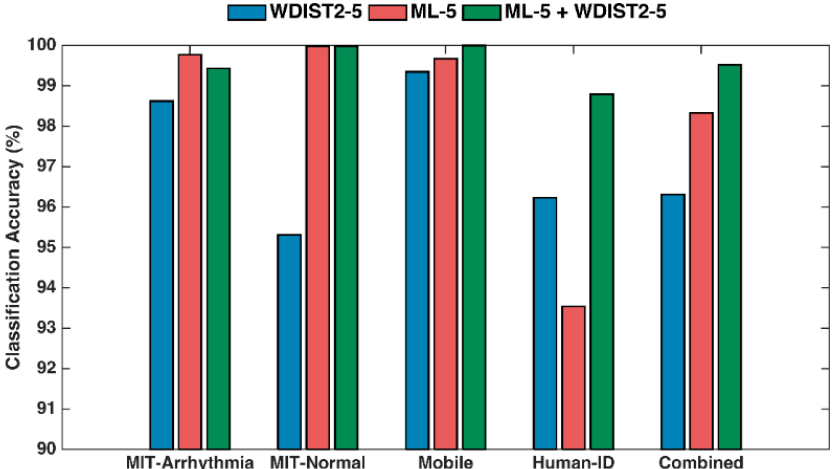
Figure 13. Comparisons of classifiers: the machine learning (ML-5), the one-to-many template matching (WDIST2-5), and the proposed two-stage classifiers (ML-5 + WDIST2-5) on the four individual datasets and the combined large dataset.